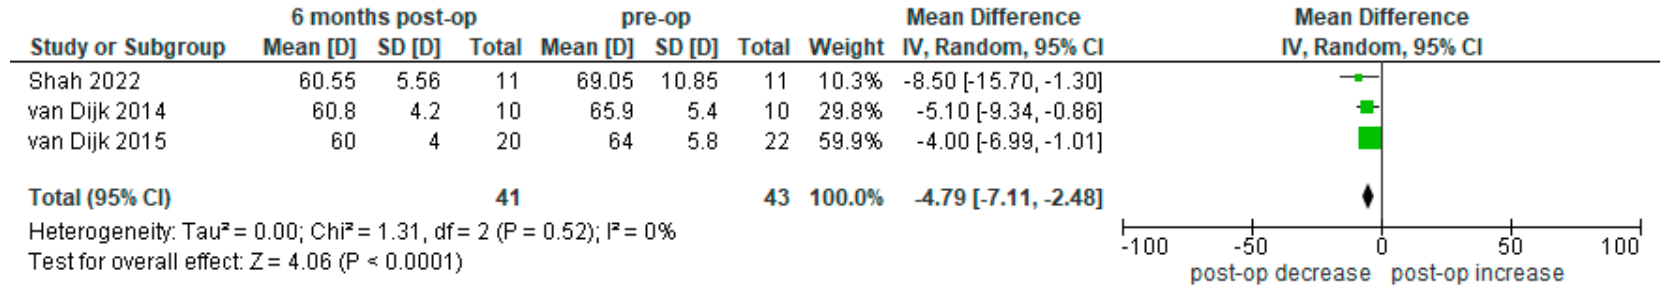
Figure A11. Di ff erence in maximum keratometry across 3 studies [27,31,35].